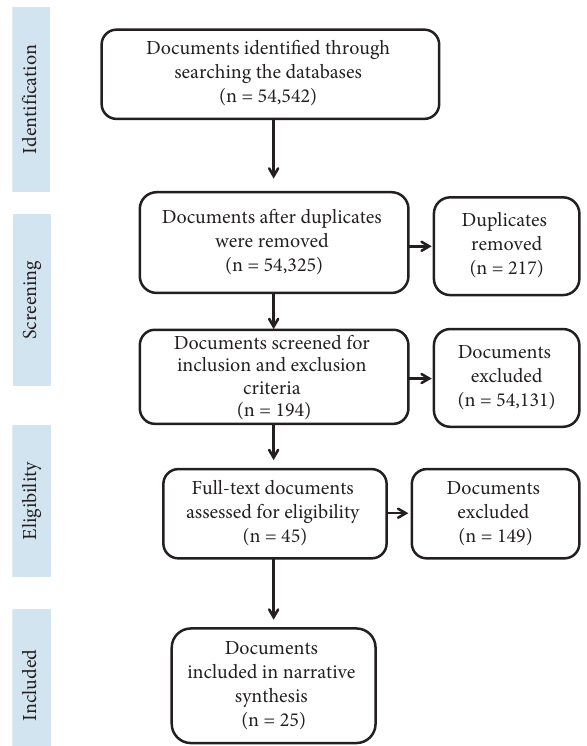
Figure 1: PRISMA flow diagram of study selection.